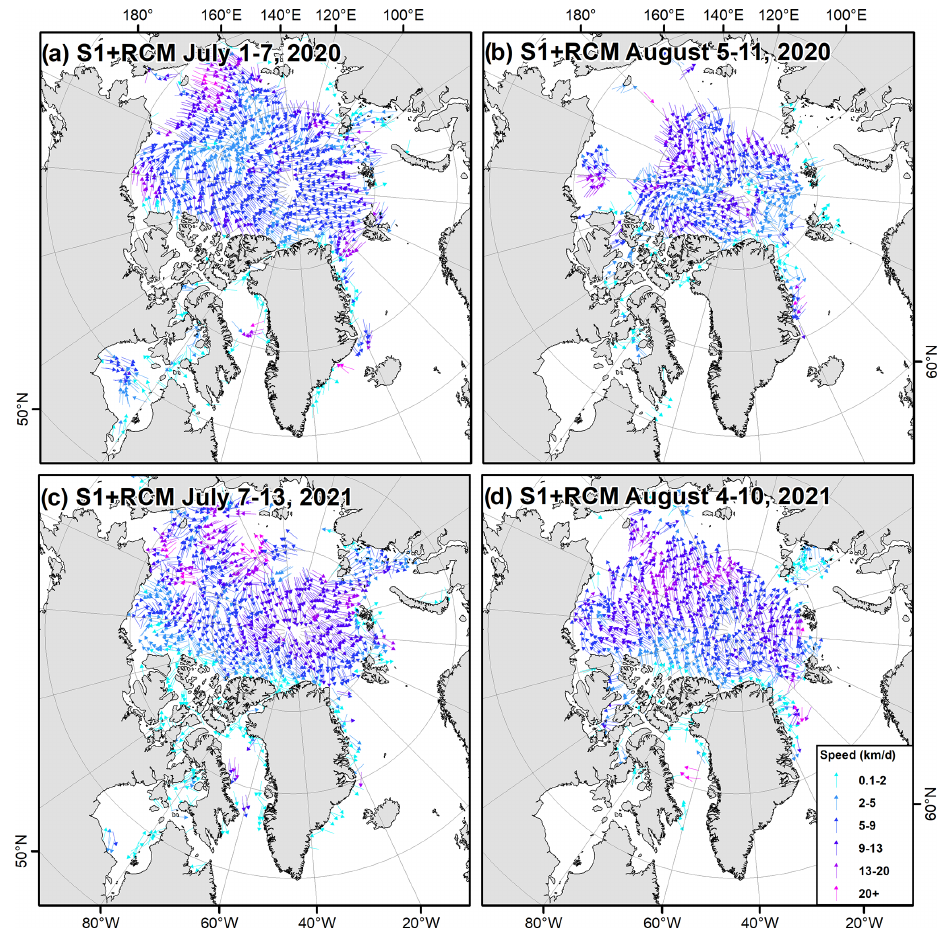
Figure 9. The spatial distribution of 25km 7d S1 + RCM sea ice motion on (a) 1–7 July 2020, (b) 5–11 August 2020, (c) 7–13 July 2021, and (d) 4–10 August 2021. Note that the white areas in the figure indicate either zero ice motion for the landfast ice or no ice motion information extracted (because of no SAR data, no ice, or no stable ice